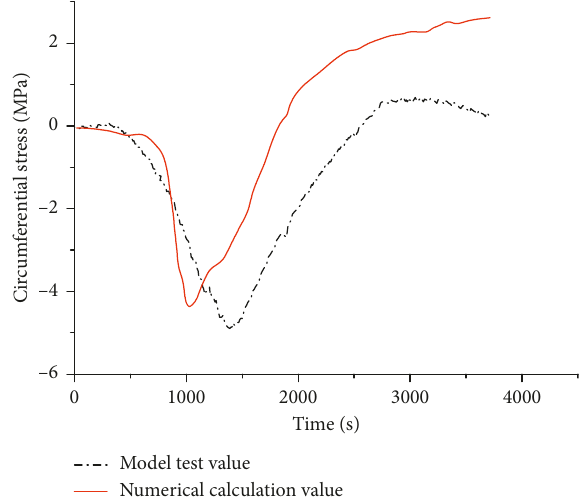
Figure 14: Curve of thermal stress of the middle layer in the simulation